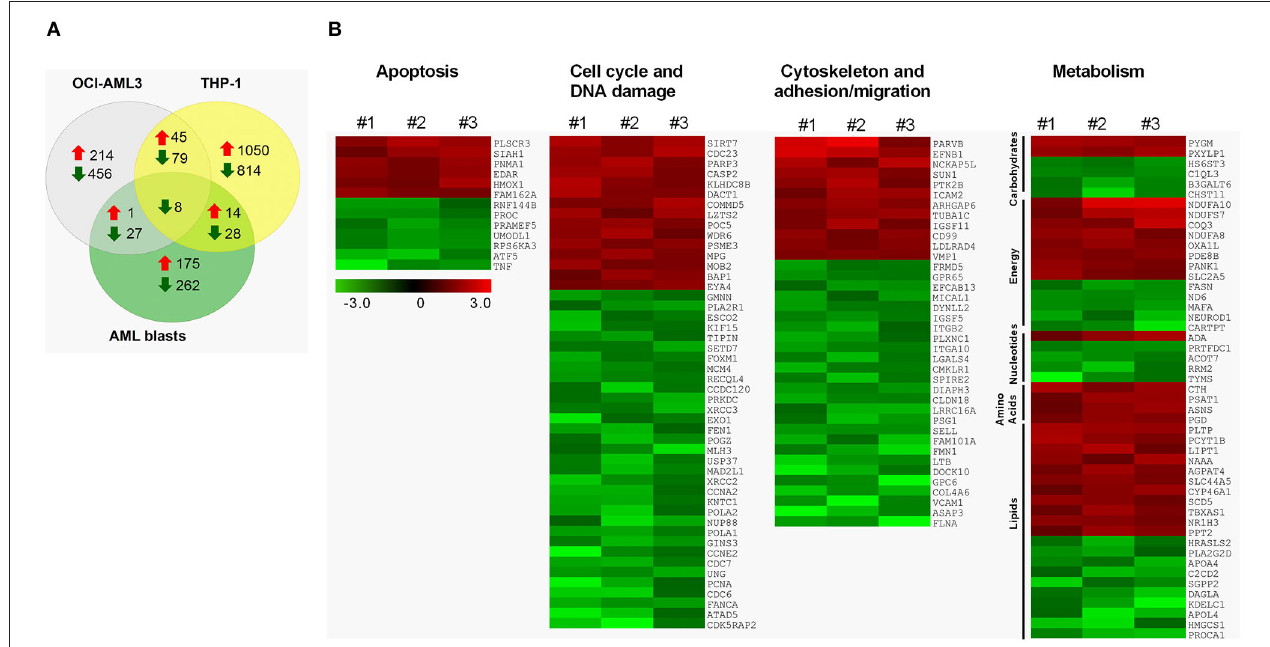
FIGURE 4 | Transcriptomic alterations induced by DEN in AML. (A) The number of upregulated and downregulated genes after 24h of denatonium exposure in primary AML cells (0.5mM), OCI-AML3 (0.1mM), and THP-1 (0.5mM) cell lines. (B) Heatmap of differentially expressed genes involved in apoptosis, cell cycle and DNA damage, cytoskeleton, cell adhesion and migration, and metabolism, following exposure to denatonium in three primary AML sample. Columns represent ratios between DEN- and vehicle-treated cells for each case. Color changes are quantified by the scale bar. Genes are ranked according to their fold